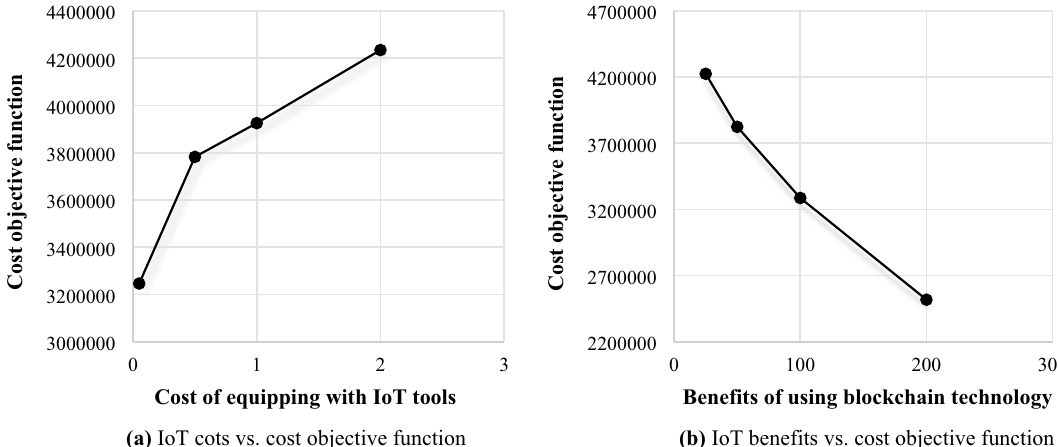
Figure 4. Relationship between blockchain adoption and cost objective